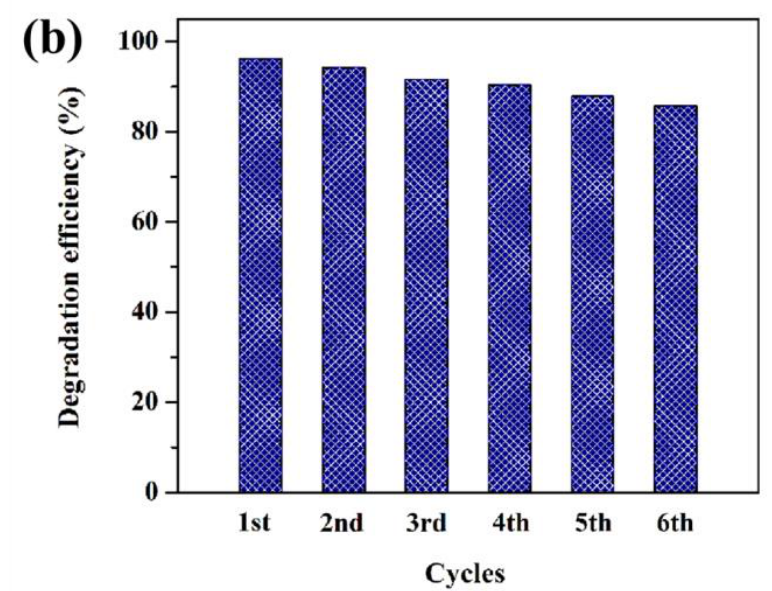
Figure 7. ( a ) TOC removal of RhB (10 mg/L, 80 mL) over Ag/AgCl/BiOCH-3 (30 mg), BiOCOOH (30 mg), or Ag/AgCl (30 mg) after 60 min of illumination; ( b ) recycling tests of Ag/AgCl/BiOCH-3 (30 mg) for RhB (10 mg/L, 80 mL) removal.